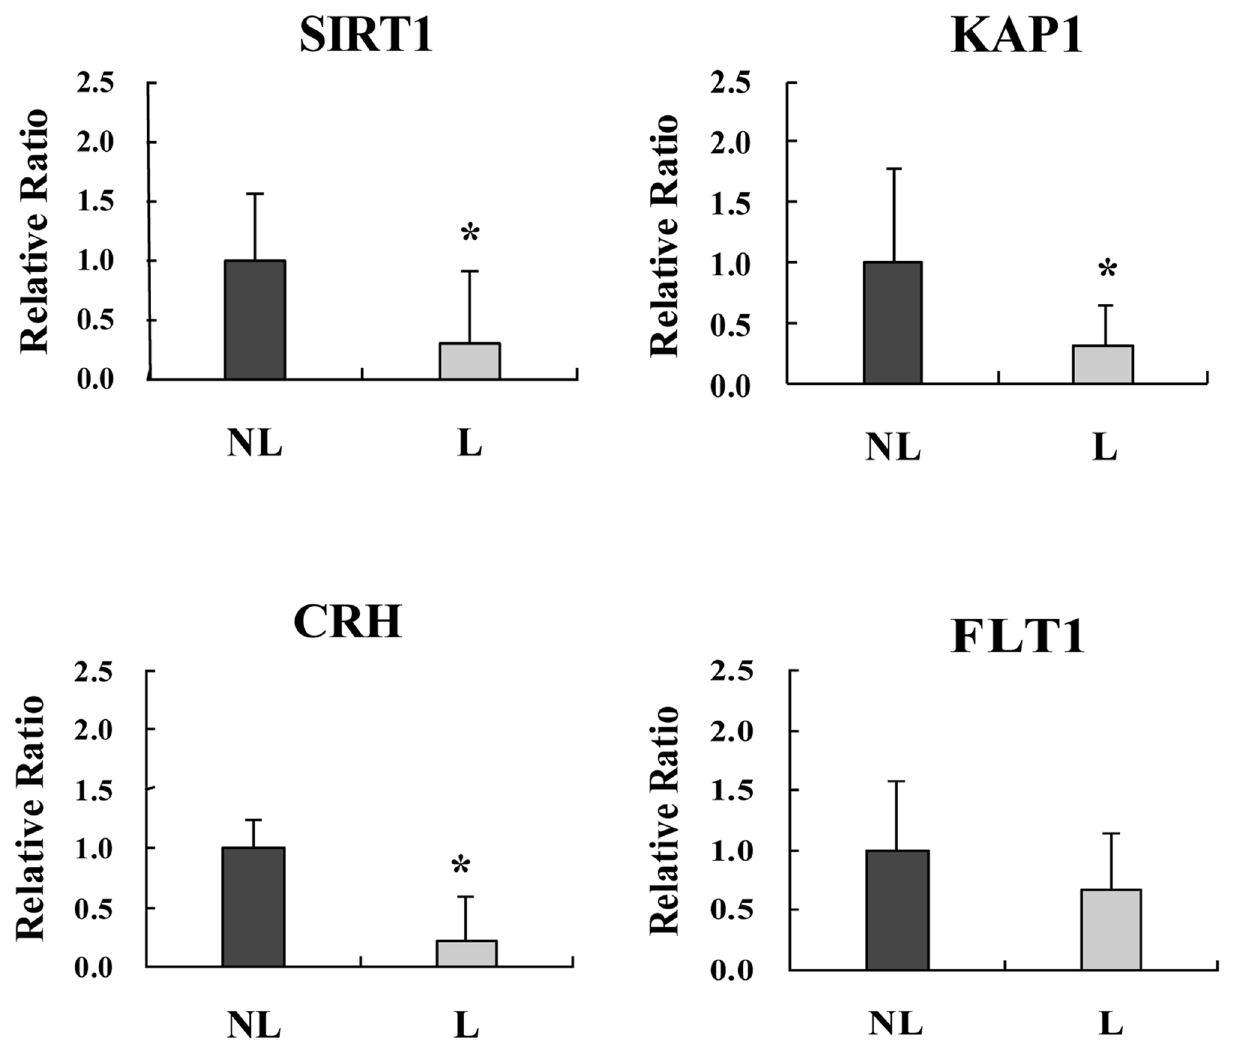
Figure 3. Real-time RT-PCR results. Graphic representations of real-time RT-PCR data for SIRT1, KAP1, CRH and FLT1. The data were normalized to 28S rRNA expression. The data are reported as means ± SD with significant differences between the non- labor group and the labor group labeled with asterisks (*, p <0.05). NL and L represent non labor placenta and labor placenta, respectively